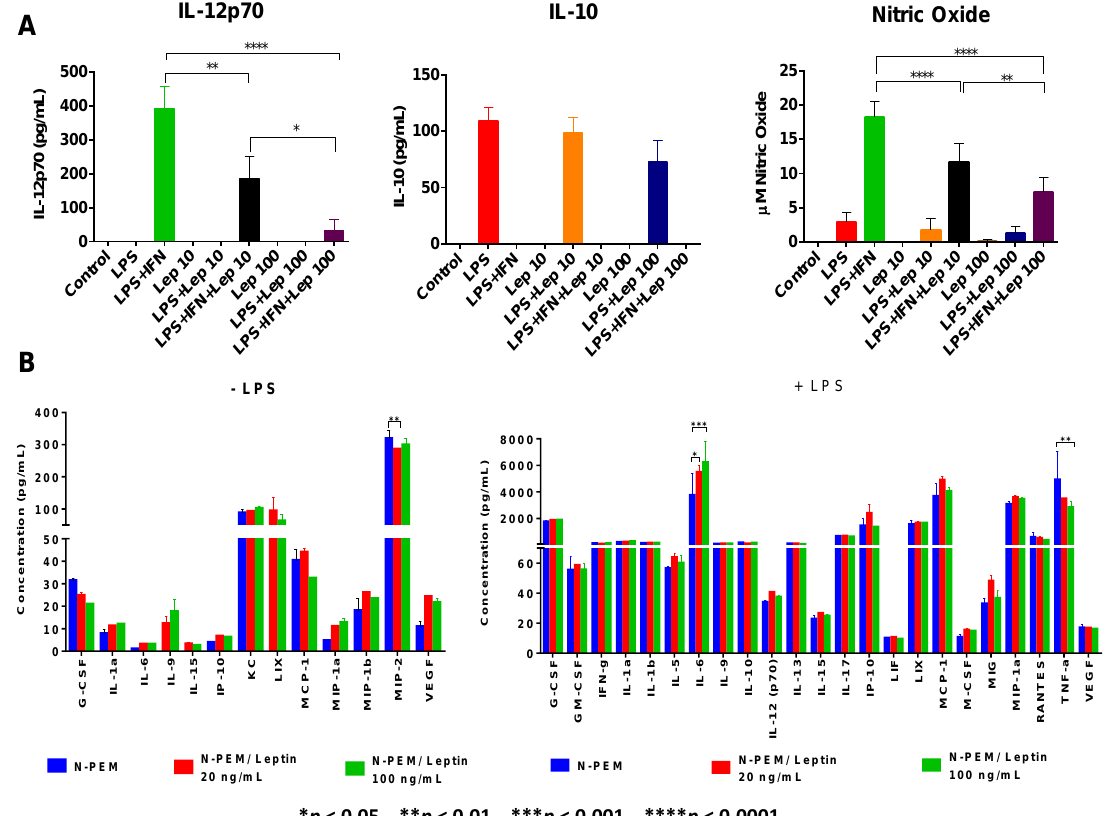
Figure 6. Leptin regulates expression of cytokines and chemokines in macrophages. Peritoneal elicited macrophages were pre-treated with increasing concentrations of leptin (0, 10 and 100 ng/mL) and activated with LPS (10 µg/mL) or with and LPS+IFNγ (IFNγ at 100 u/mL) for 20 h, and supernatants were collected and tested for IL-12p70 and IL-10 expression by ELISA and for nitric oxide (NO) production via the Griess reaction ( A ). increasing concentrations of leptin (0, 20 and 100 ng/mL) for 20 h and their